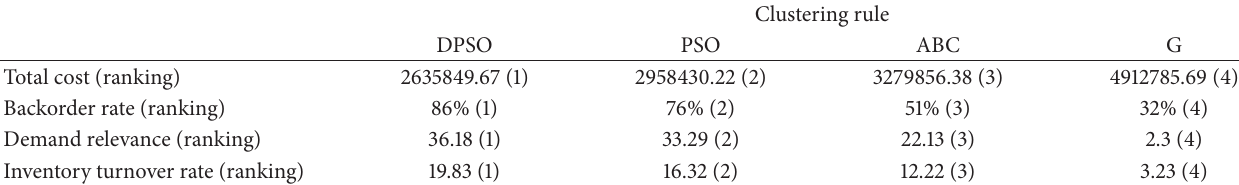
Table 1: Comparison of single-objective target values obtained using various clustering methods.